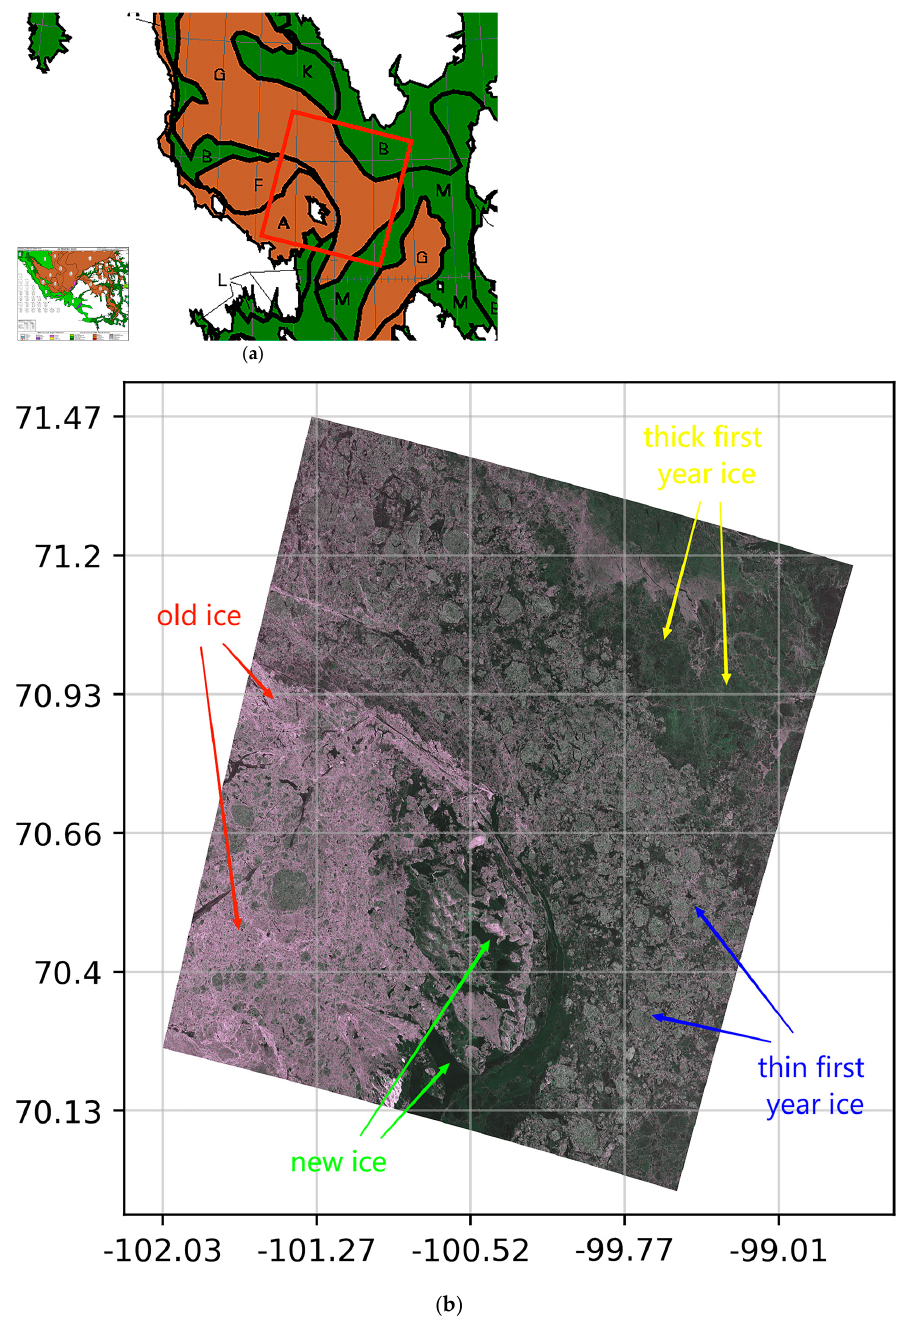
Figure 3. An example of different sea ice type selection: ( a ) ice chart released by CIS on 24 February 2020; ( b ) Gaofen-3 pseudocolor image (scene 19 in Table 1).